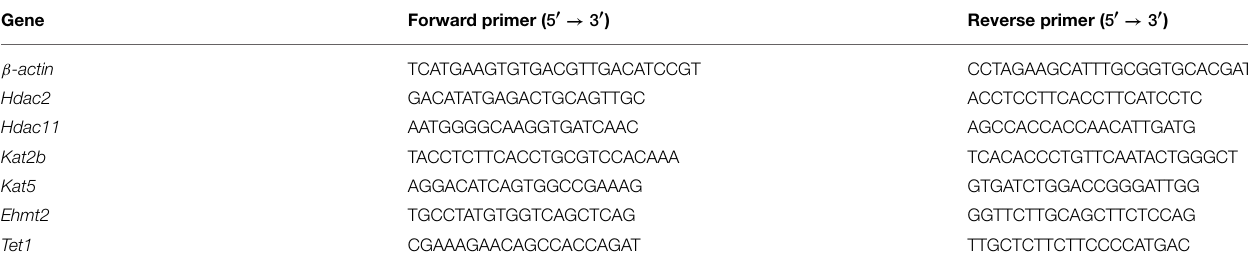
TABLE 1 | Primer sequences for RT-qPCR experiments.